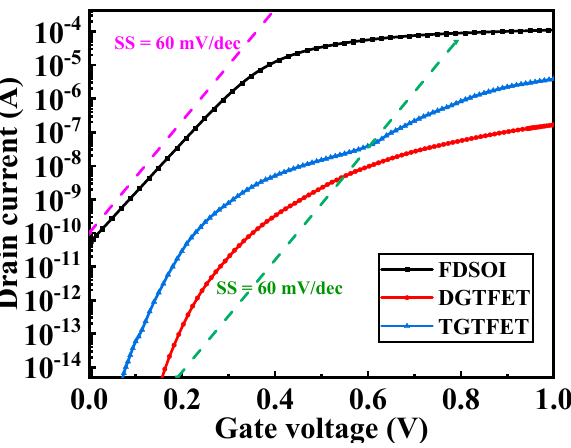
Figure 3. Transfer characteristics for TGTFET, DGTFET, and FDSOI at V d = 0.5 V.